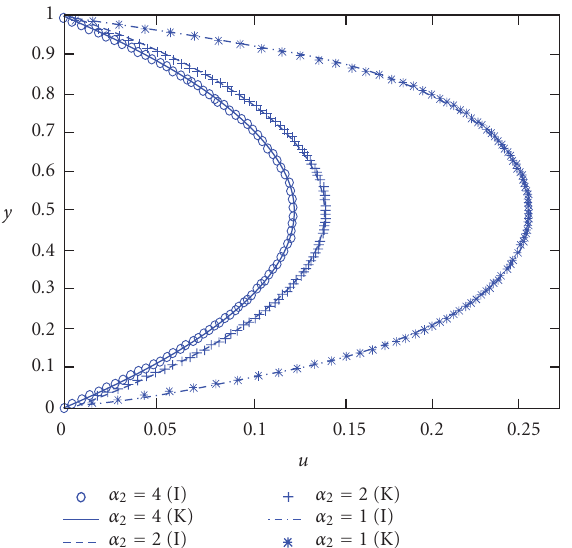
Figure 4.2. Velocity profiles for various values of α 2 and fixed α 1 = 1 (I: Wang et al. solution; K: our solution) for dp/dx = −